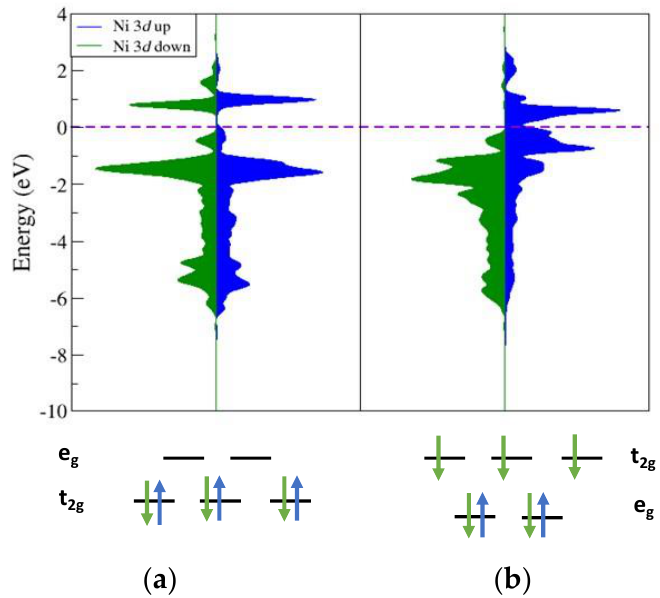
Figure 8. PDOS of the Ni d-states in NMC at Li x = 0.22 for ( a ) Ni atom in O − M − O layer and ( b ) Ni that dropped into the Li channel, resulting in a tetrahedral coordination. Color scheme follows that of Figure 6 fillings.